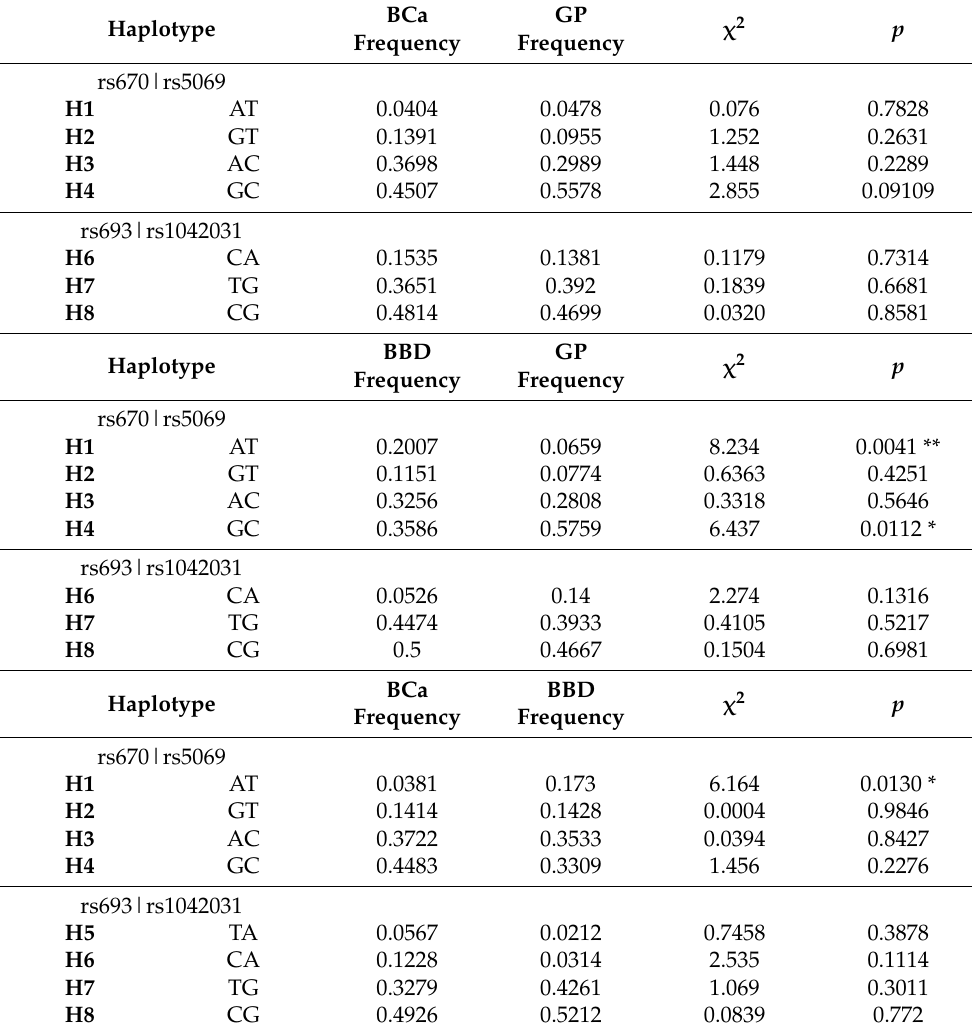
Table 4. Haplotype association analysis in breast cancer, benign breast disease, and general popula- tion